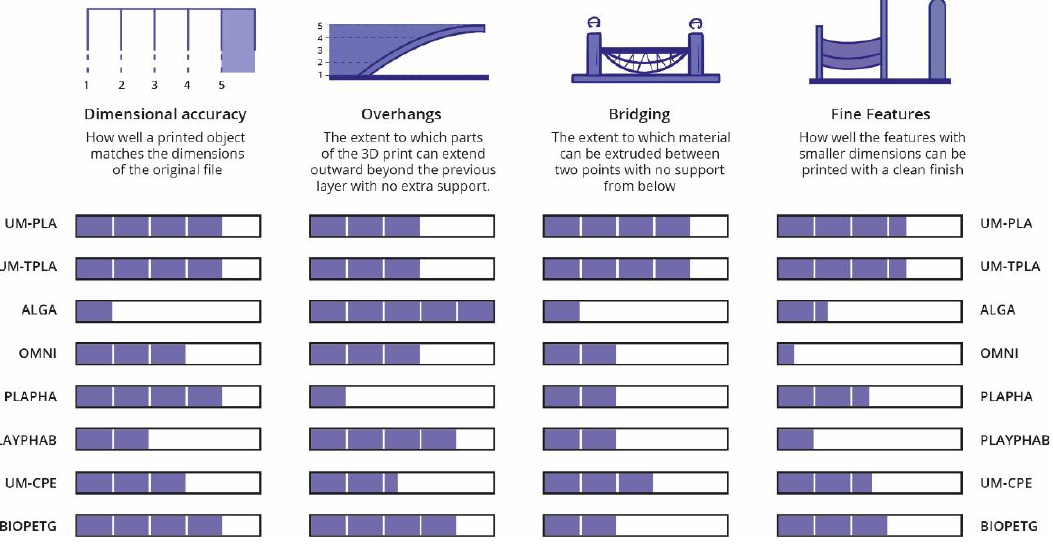
used for universal comparisons.